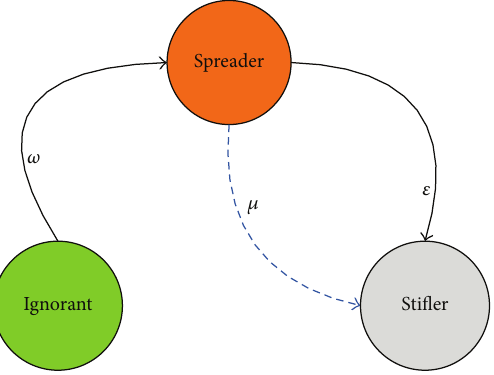
Figure 5: Information diffusion model